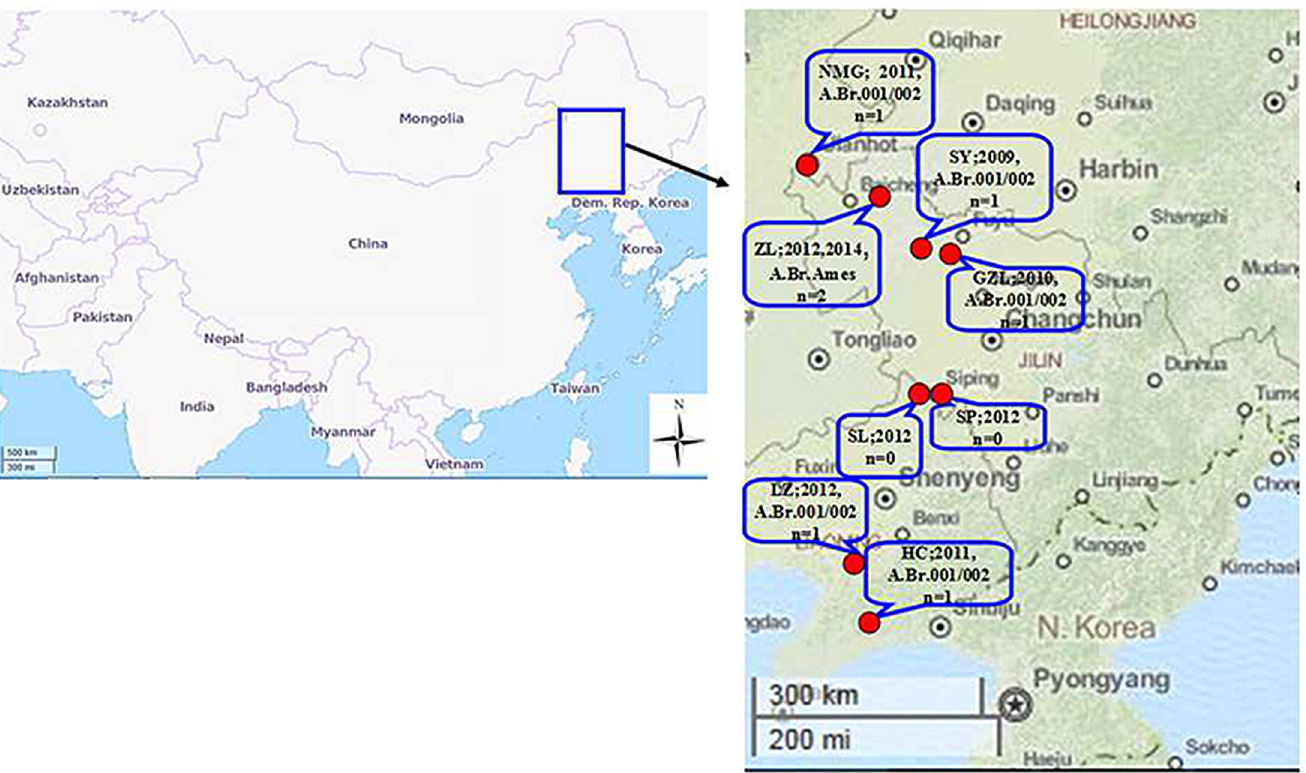
Fig 1. Geographical distribution of B . anthracis isolated in the North-East of